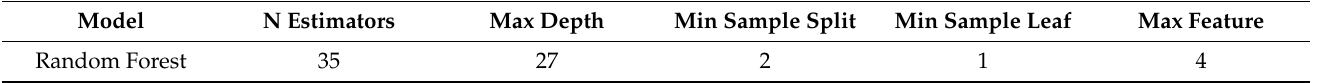
Table 4. Data of tensile strength